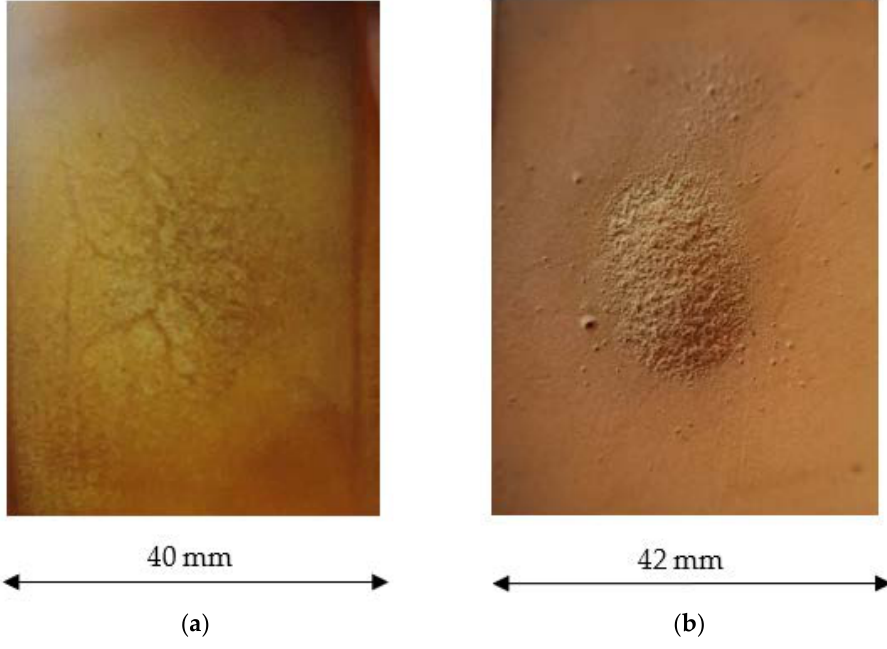
Figure 9. Wear of the unfilled epoxy compound surface at an impingement angle of 90° at temperatures: ( a ) up to 100 °C; ( b ) 180 °C.